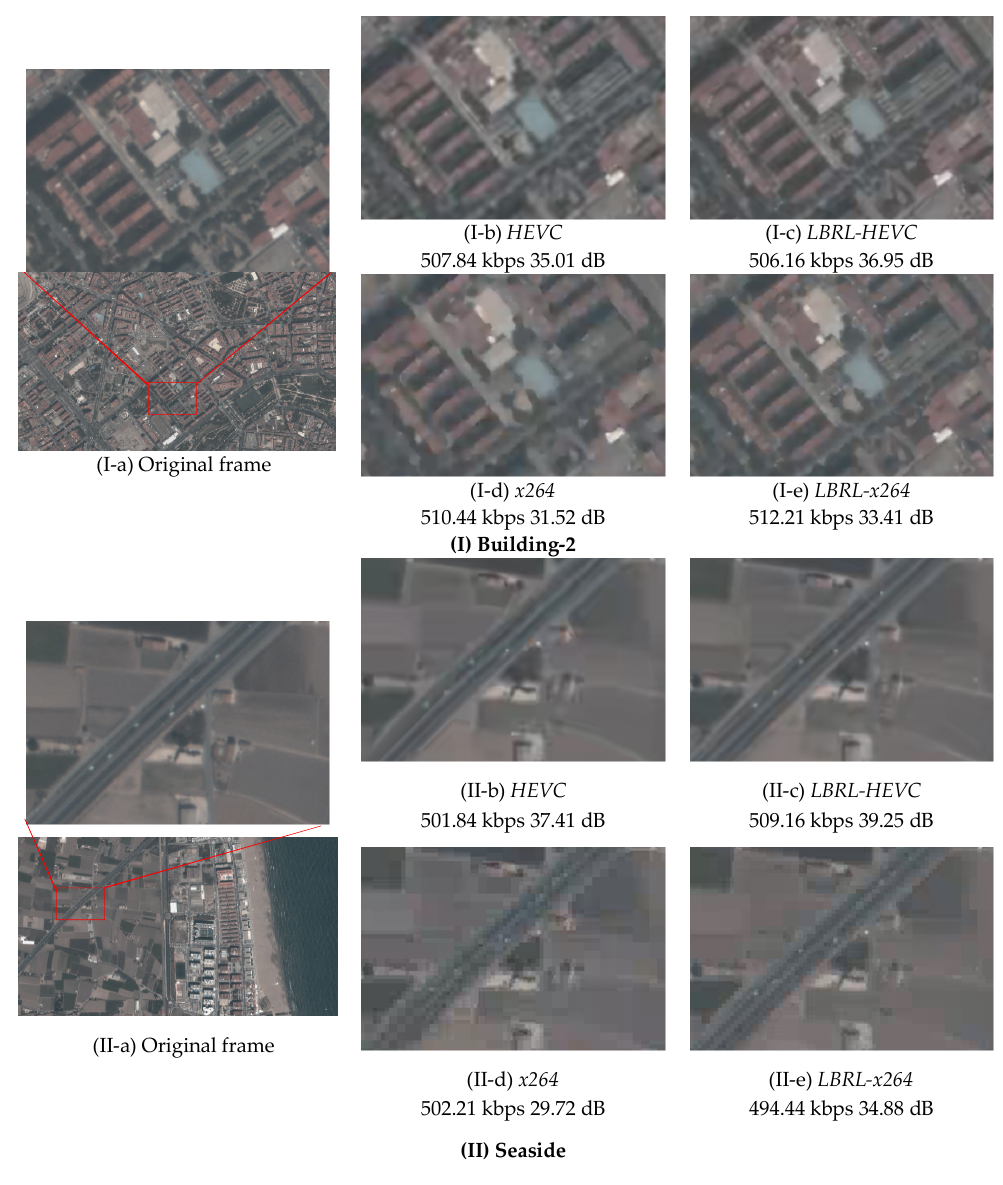
Figure 11. Visual comparison between HEVC , LBRL-HEVC , x264 , and LBRL-x264 .